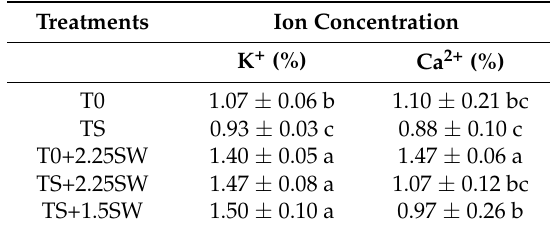
Table 3. The ion concentration (K + and Ca 2+ ) in the leaves of 2 year old Hass avocado plants grown under different salt and seaweed extract (T0: distilled water, TS: saline water (9 mM NaCl), T0 + 2.25SW: distilled water + 2.25 mL seaweed, TS + 2.25SW: saline water (9 mM NaCl) + 2.25 mL seaweed T0 + 1.5 mL seaweed) for 240 days with 6 replicates per treatment.